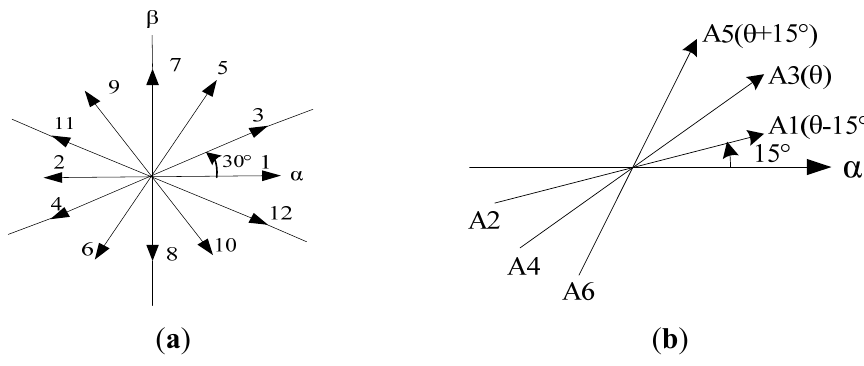
Figure 7. ( a ) Voltage vectors used in the first process; and ( b ) Voltage vectors used in the second